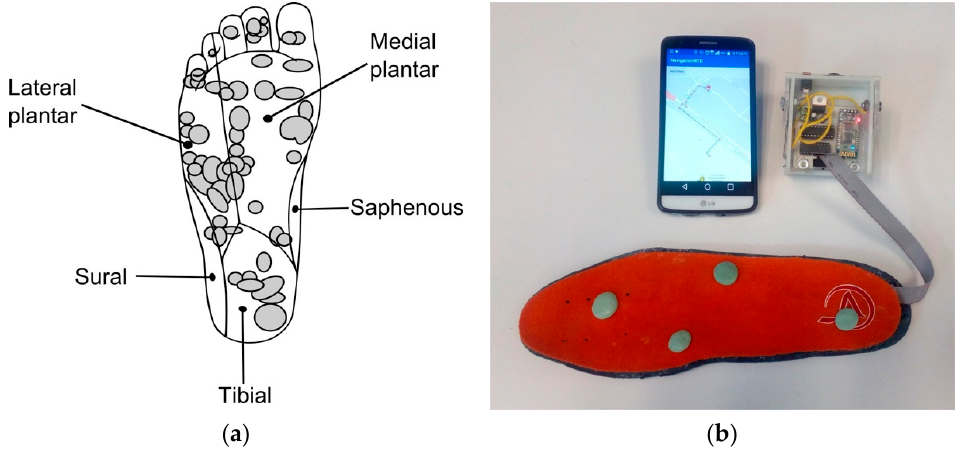
Figure 4. User interface: ( a ) FAI afferents on the foot sole and ( b ) prototype.